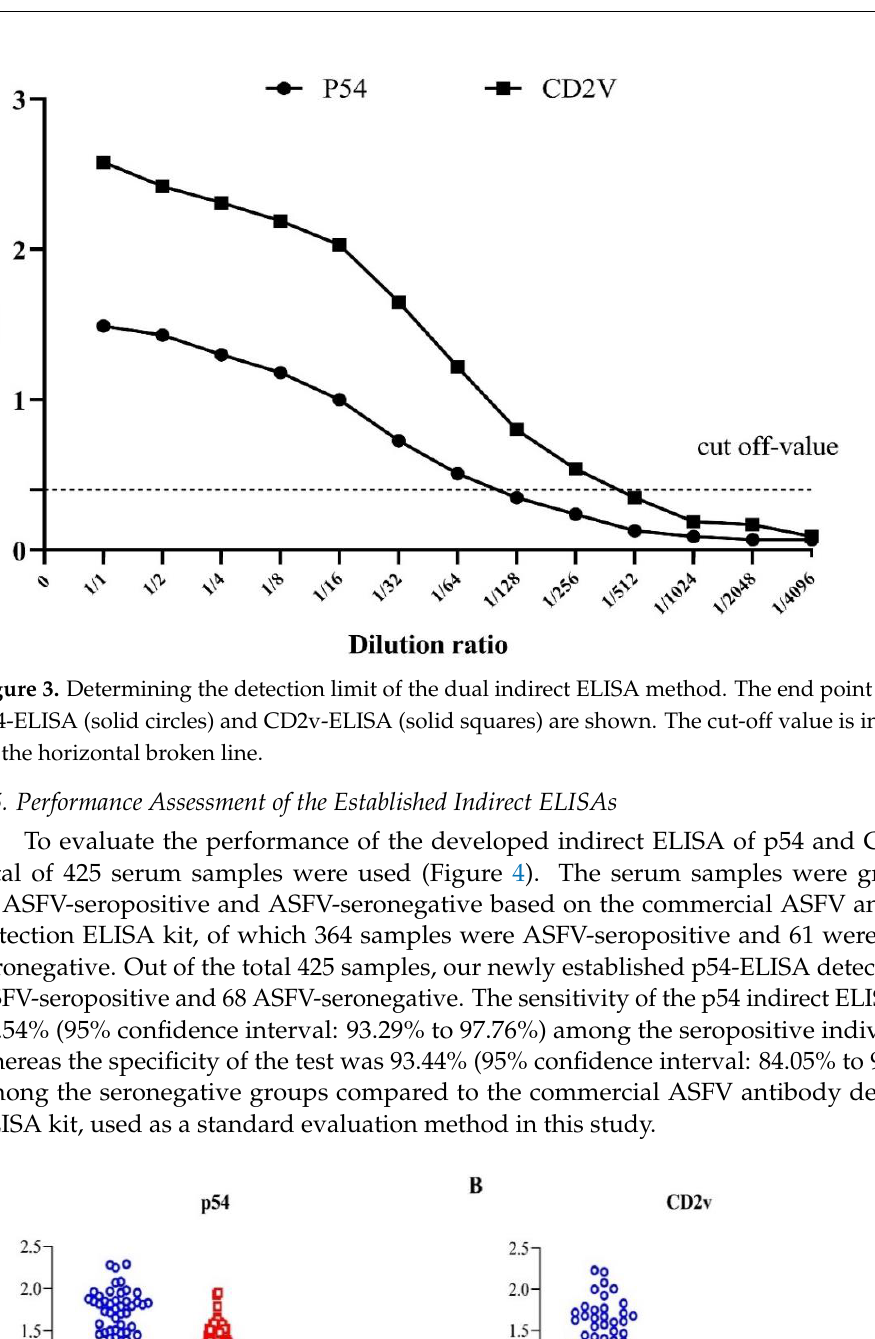
Figure 2. Specificity test of the dual indirect ELISA method. Only ASFV-positive serums show an OD value greater than the cut-off value.